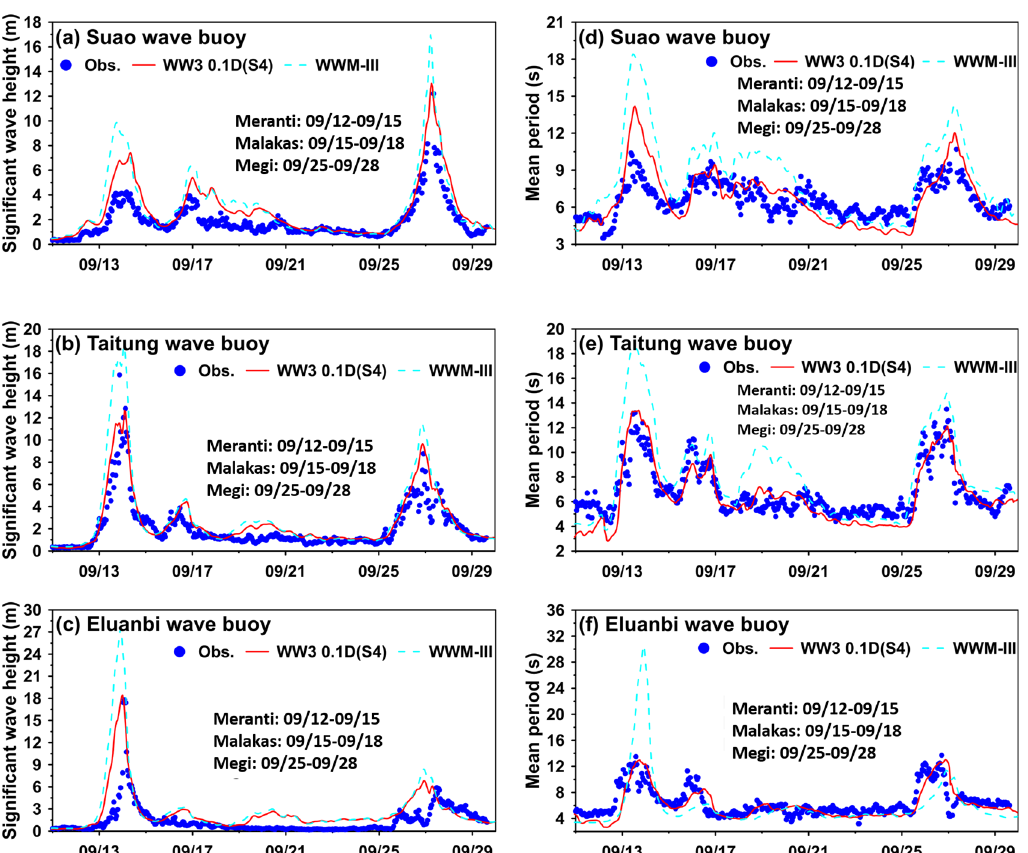
Figure 18. Comparison of the hourly significant wave height ( a – c ) and mean period ( d – f ) simulations using the WW3 (0.1D) and WWM-III models for the ( a , d ) Suao, ( b , e ) Taitung, and ( c , f ) Eluanbi wave buoys.